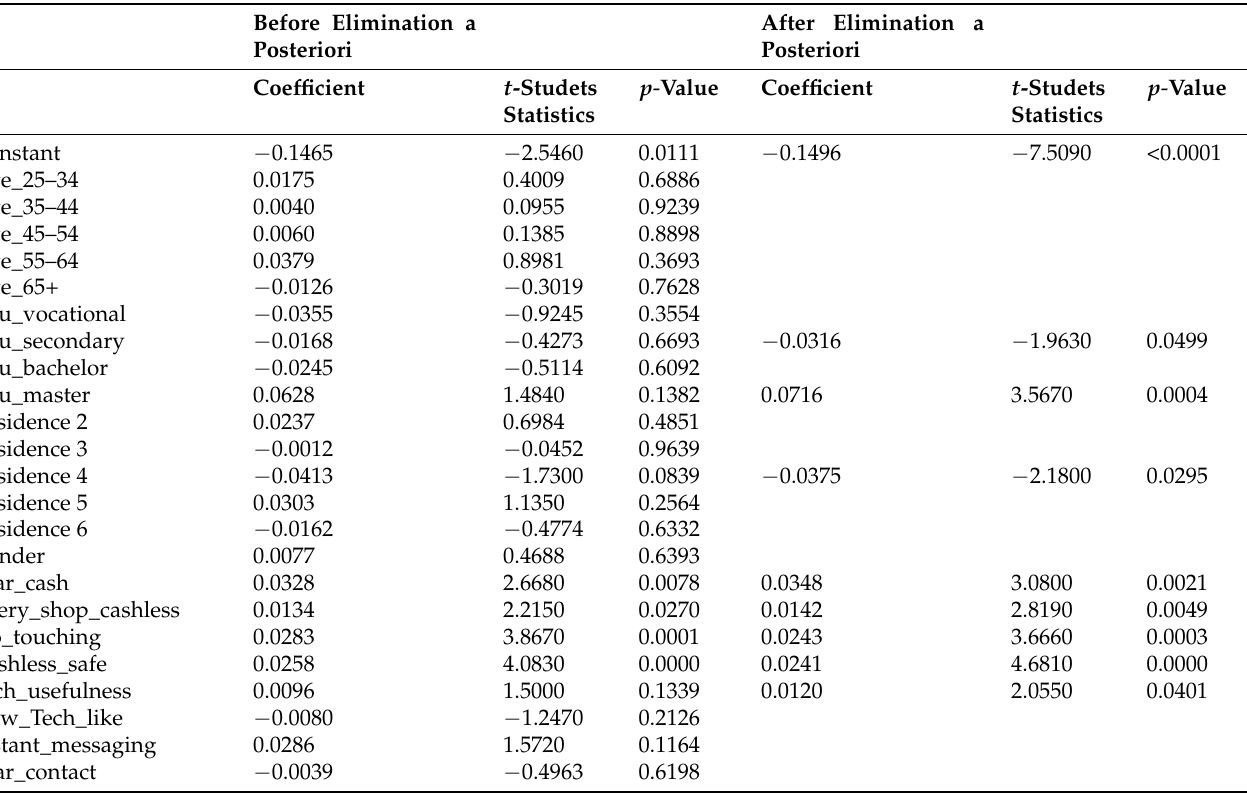
Table 8. The results of the estimated LPM model before and after elimination a posteriori ( n =